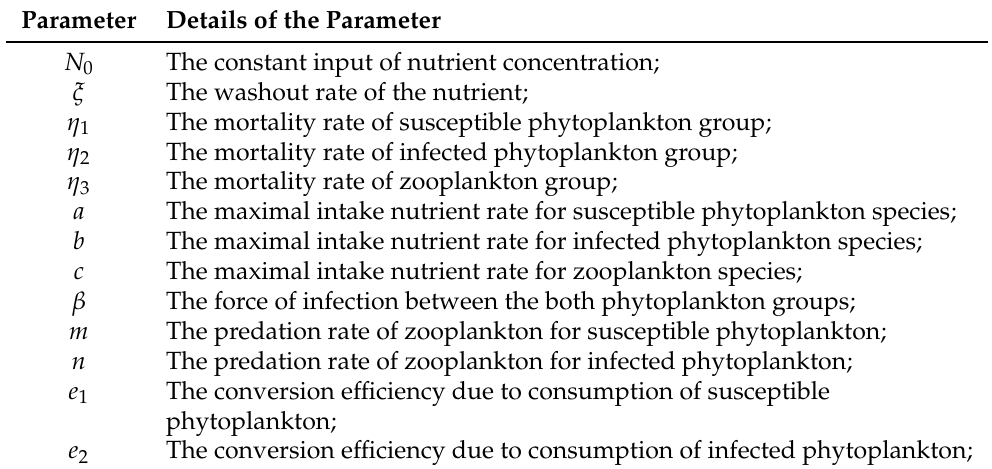
Table 1. The details of parameters of the NPZ model